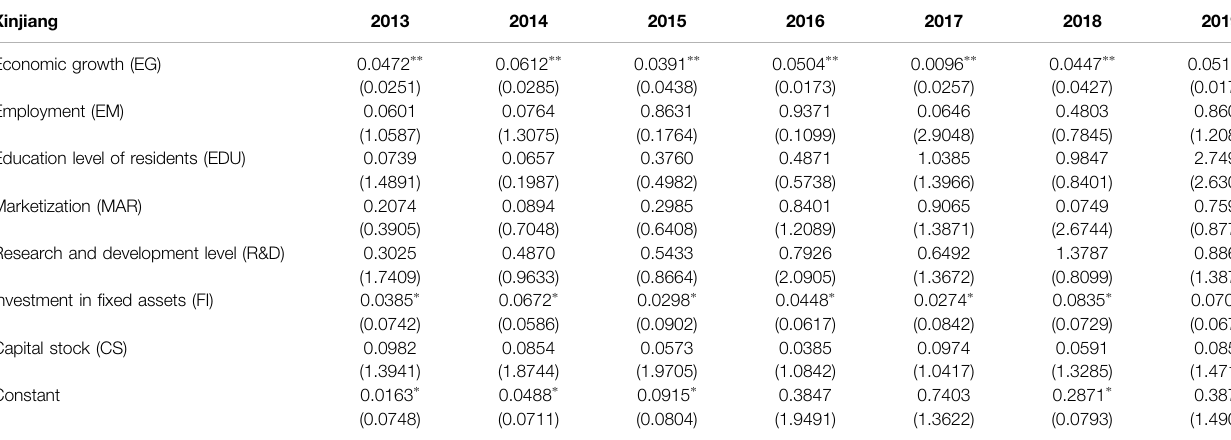
TABLE 16 | Driving force of Xinjiang health tourism industry convergence.